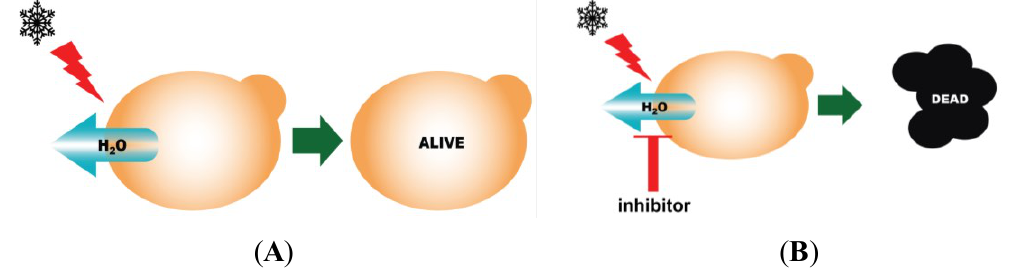
Figure 2. Schematic representation of the yeast-based freeze-thaw assay. If the yeast expresses an active AQP, they will survive a freeze-thaw challenge ( A ); If an inactive AQP is expressed, or if an active AQP expressed is exposed to an AQP inhibitor, the protective effect is lost and the yeast will die ( B ).